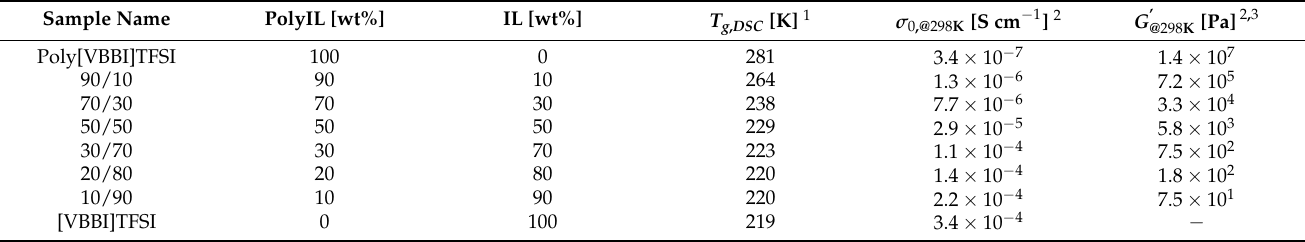
Table 1. Overview of the samples: The names correspond to the mixing ratios of the pure polymerized ionic liquid (polyIL) and ionic liquid (IL) in each weight percent. The glass transition temperature ( T g ) from DSC measurements, the ionic conductivity ( σ 0 ) and the storage modulus ( G (cid:48) ) at 298 K and ω = 100 rad s − 1 are